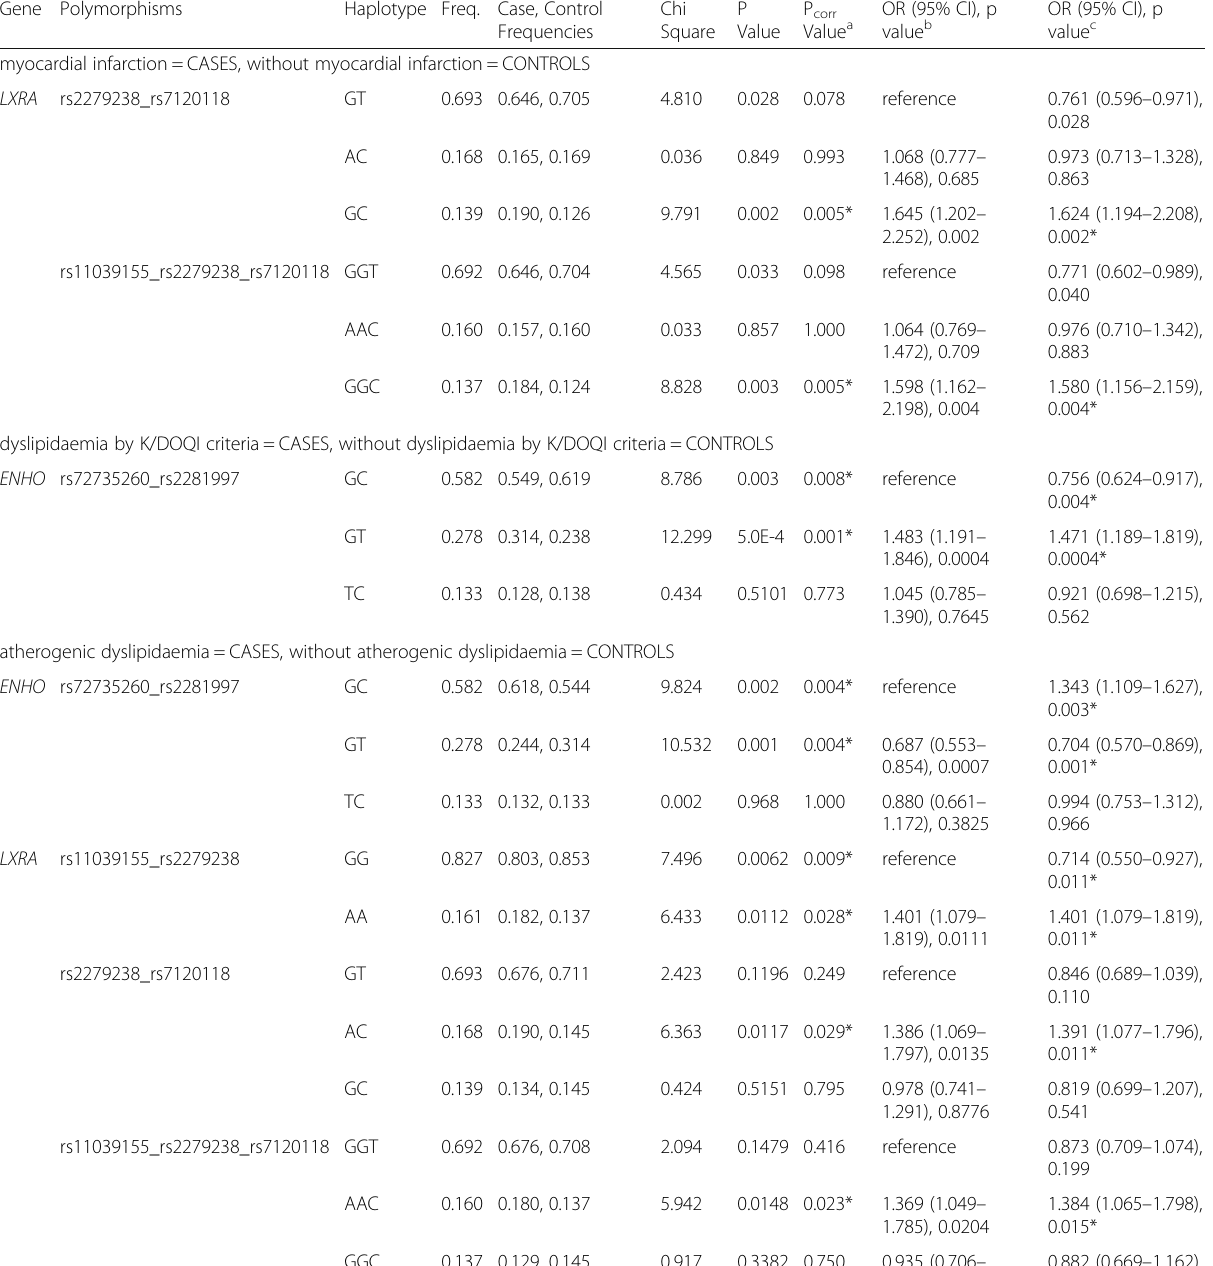
Table 3 Haplotypes of the tested genes concerning the analysed phenotypes in HD patients Gene Polymorphisms Haplotype Freq. Case, Control